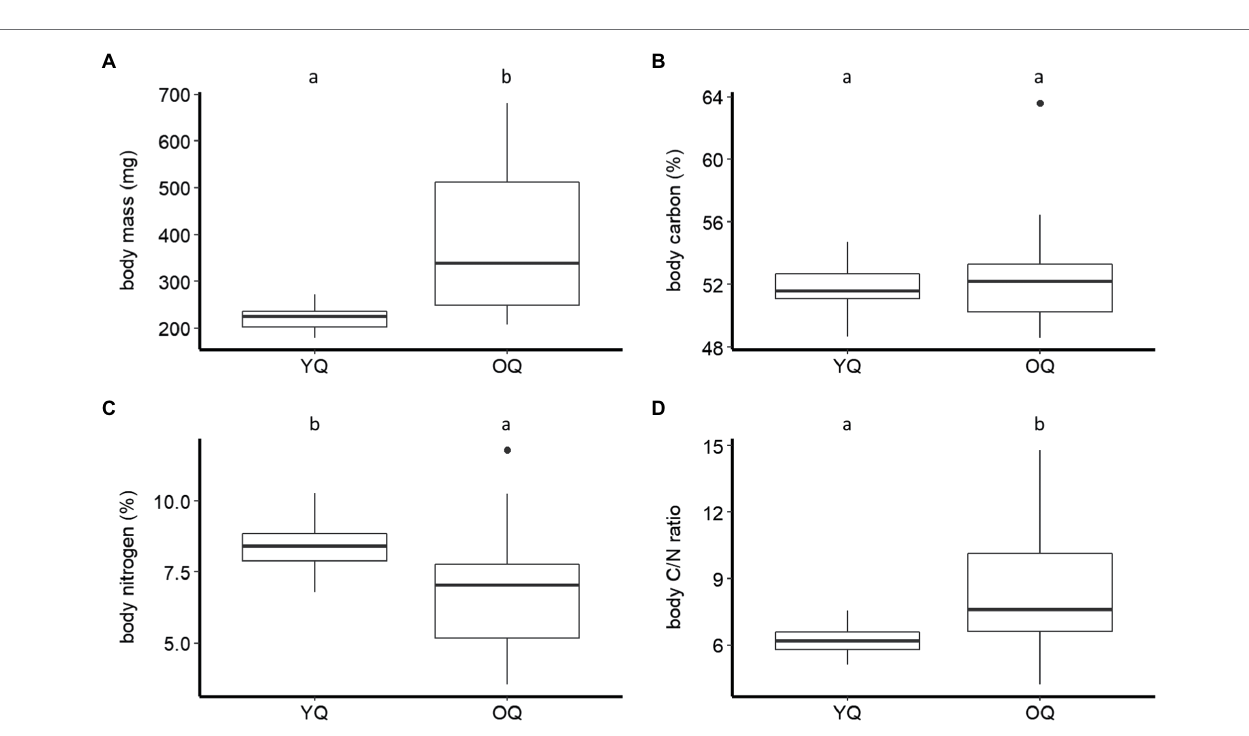
FIGURE 2 | Boxplots of dry body mass (A) , carbon, (B) nitrogen percentage (C) , and carbon-to-nitrogen ratio (D) of young queens (YQ) and ovipositing queens (OQ) of B. terrestris . Significantly different means are denoted above each panel by use of compact letter